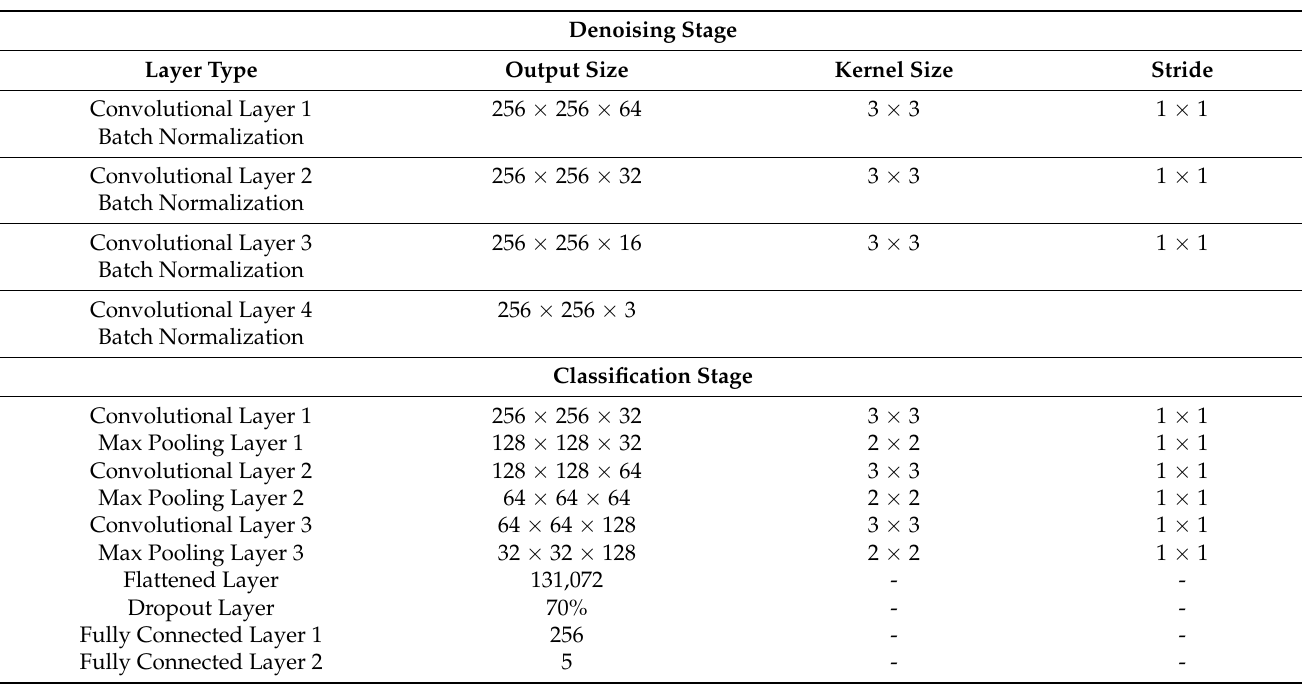
Table 1. Structure of the proposed cascaded